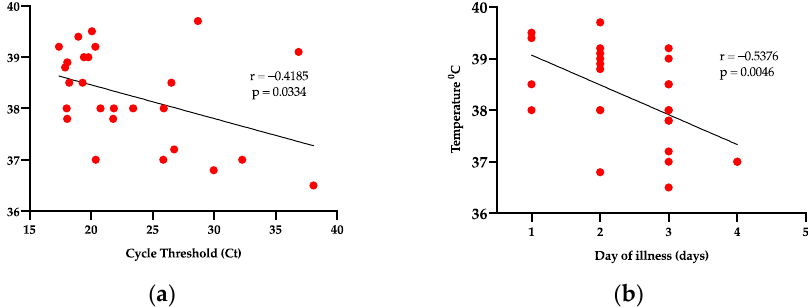
Figure 4. Correlation analysis of temperature against cycle threshold and day of illness. ( a ) Body temperature vs. cycle threshold. ( b ) Body temperature vs. day of illness.